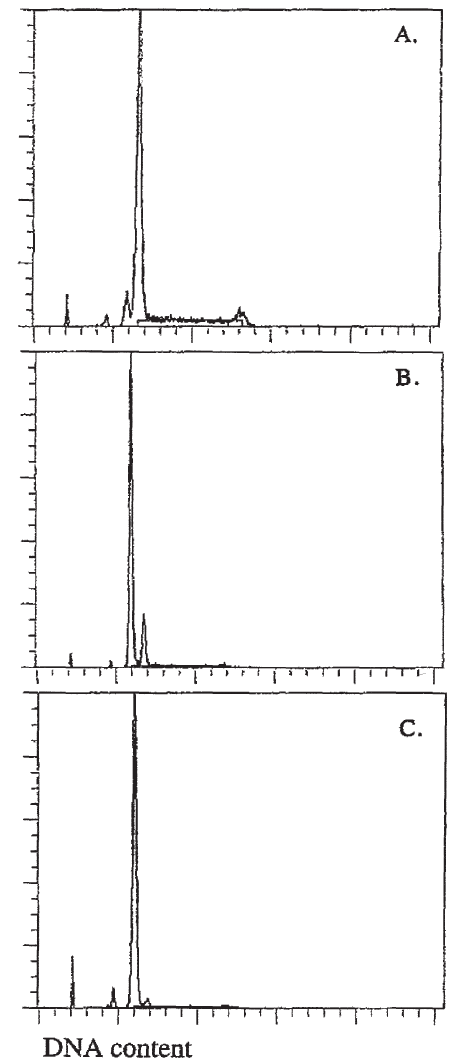
Fig. 2. Flow cytometric DNA index (DI FCM ) analysis on bone marrow samples from patient no 81 at diagnosis, treatment day 15 and